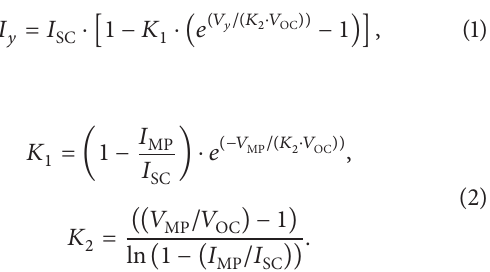
wind speed and the output parameters are the PV current, PV voltage, and PV power.